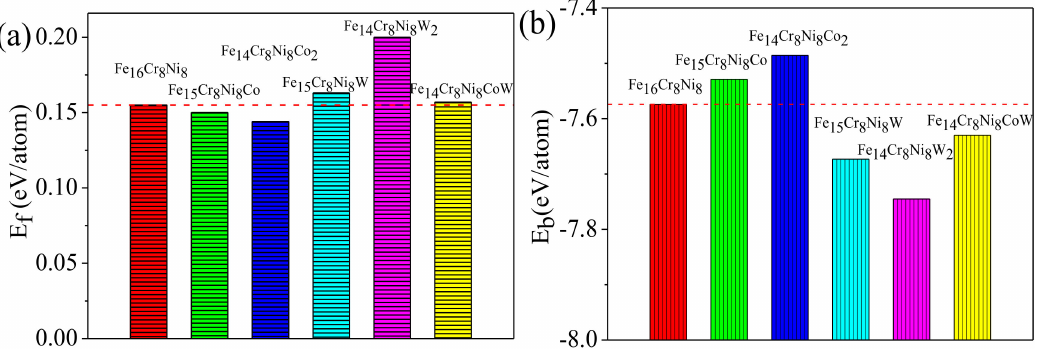
Figure 3. Forming energy E f and binding energy E b of di ff erent systems: ( a ) E f and ( b ) E